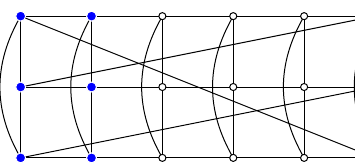
C 6 ∼ = C 12 (1, 6) with a zero forcing set. (cid:49)